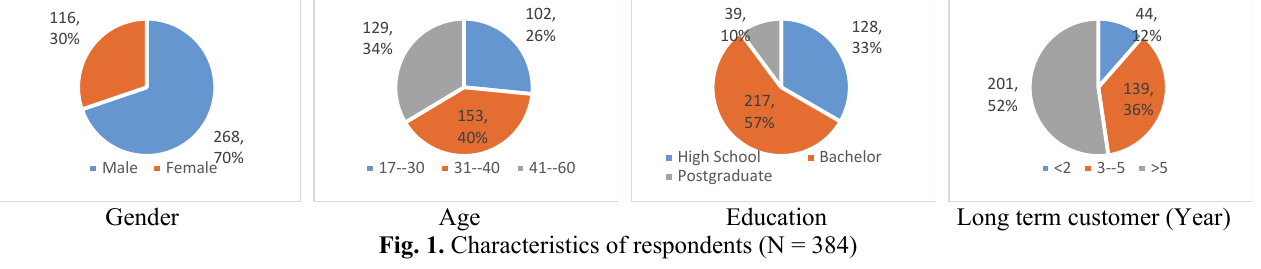
Fig. 1. Characteristics of respondents (N =